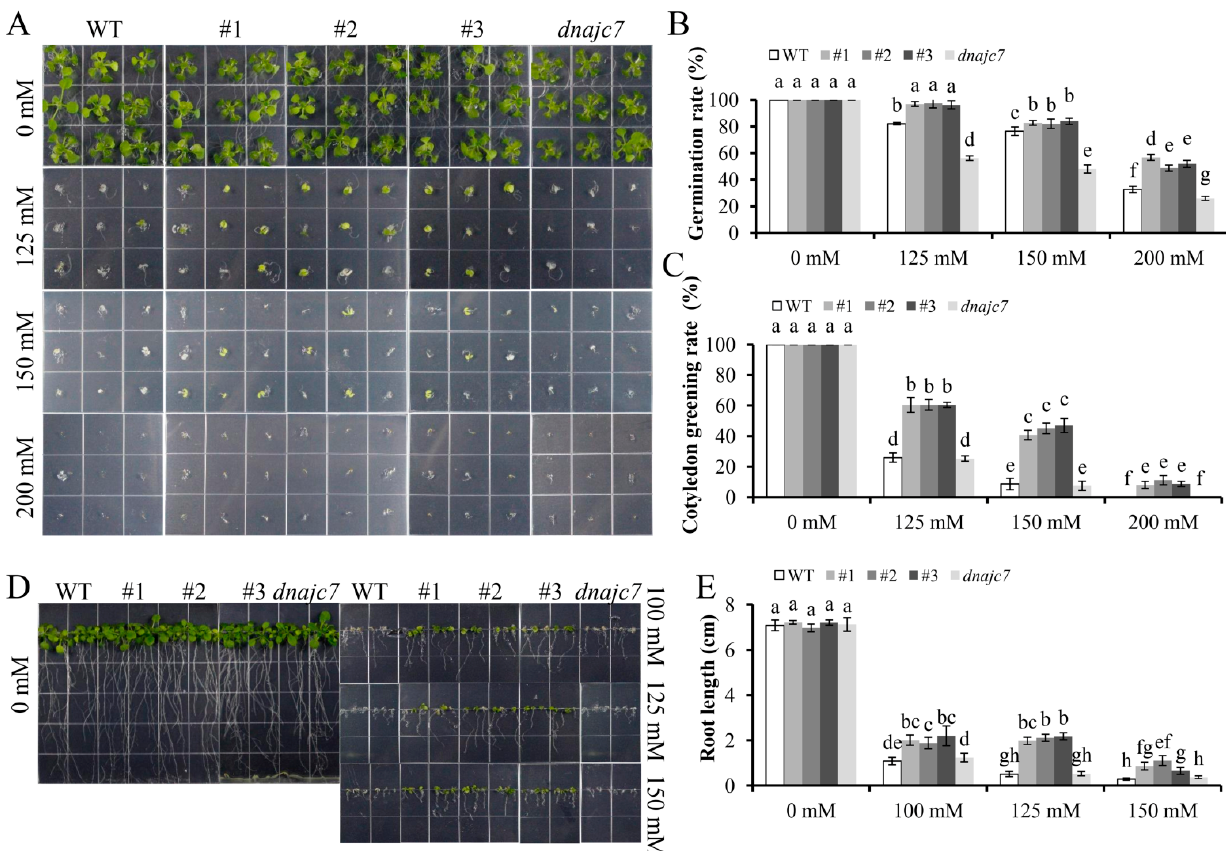
Figure 7. The effect of GmDNAJC7 ectopic expression on Arabidopsis tolerance to NaCl treatment. ( A ) Seed germination assay of different Arabidopsis lines on 1/2 MS agar plates and 1/2 MS supplied with various concentrations of NaCl. Photographs were taken 10 days after treatment. WT: wild type; #1, #2, #3: Arabidopsis lines overexpressing GmDNAJC7; dnajc7 : Arabidopsis mutant. ( B , C ) Seed germination rates after five days and cotyledon greening after 10 days for different Arabidopsis lines as shown in A. ( D ) Phenotypes of Arabidopsis lines subjected to 0, 100, 125, and 150 mM NaCl treatment for 10 days, respectively. ( E ) Root lengths of Arabidopsis lines as shown in ( D ). Root lengths were analyzed using ImageJ software. Bars represent the mean values ± standard deviations of three independent experiments and each repeat contained at least four independent plants per line for each treatment ( n ≥ 12). Bars with the same letters in lowercase above bars indicate no significant differences at the 0.05 level according to the Duncan’s multiple range tests.